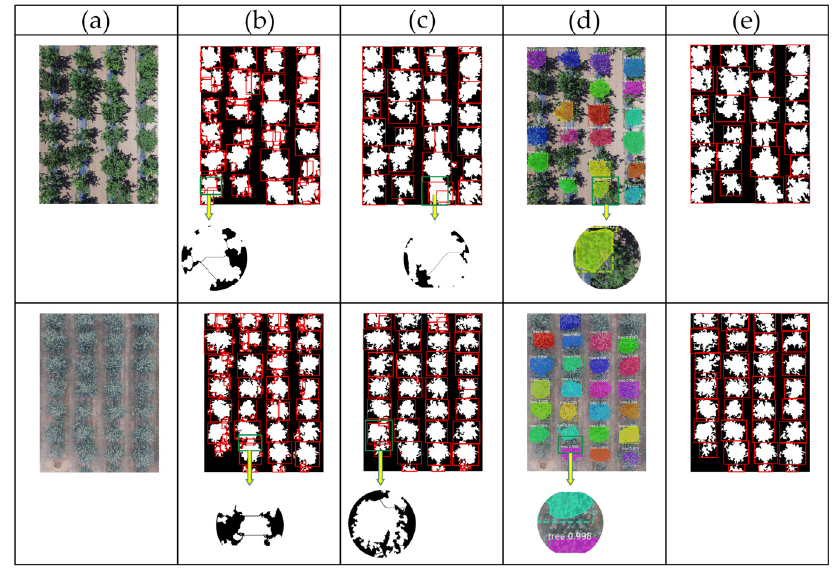
Figure 14. Comparison of different segmentation results: ( a ) original images; ( b ) traditional Watershed algorithm; ( c ) improved Watershed algorithm; ( d ) Mask-RCNN algorithm; ( e ) our algorithm.